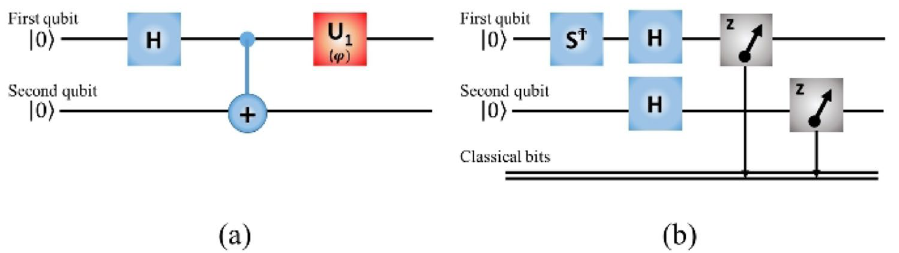
1 GHZ 2 11 00 e i ϕ ( , √ 2 � = | | � | � +